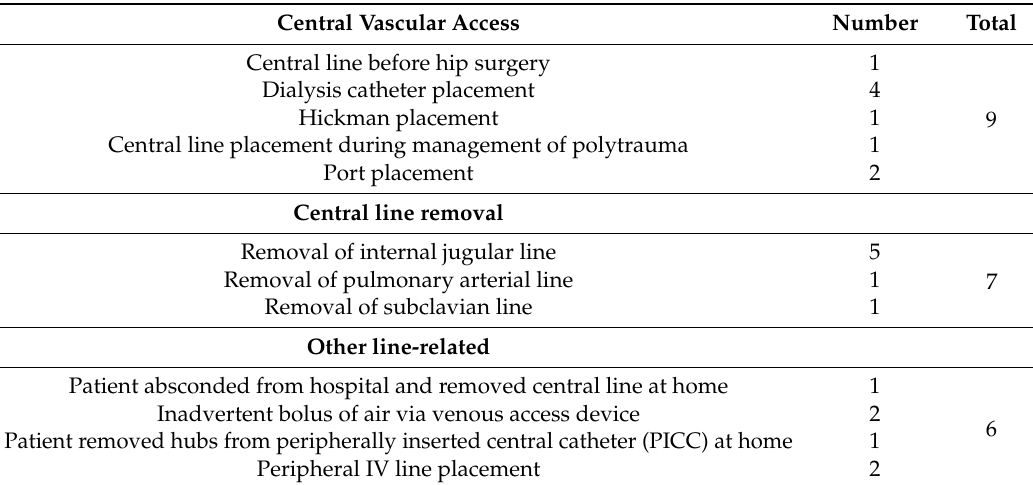
Table 3. Cases of air embolism occurring related to the use, placement, or removal of peripheral or central venous access.